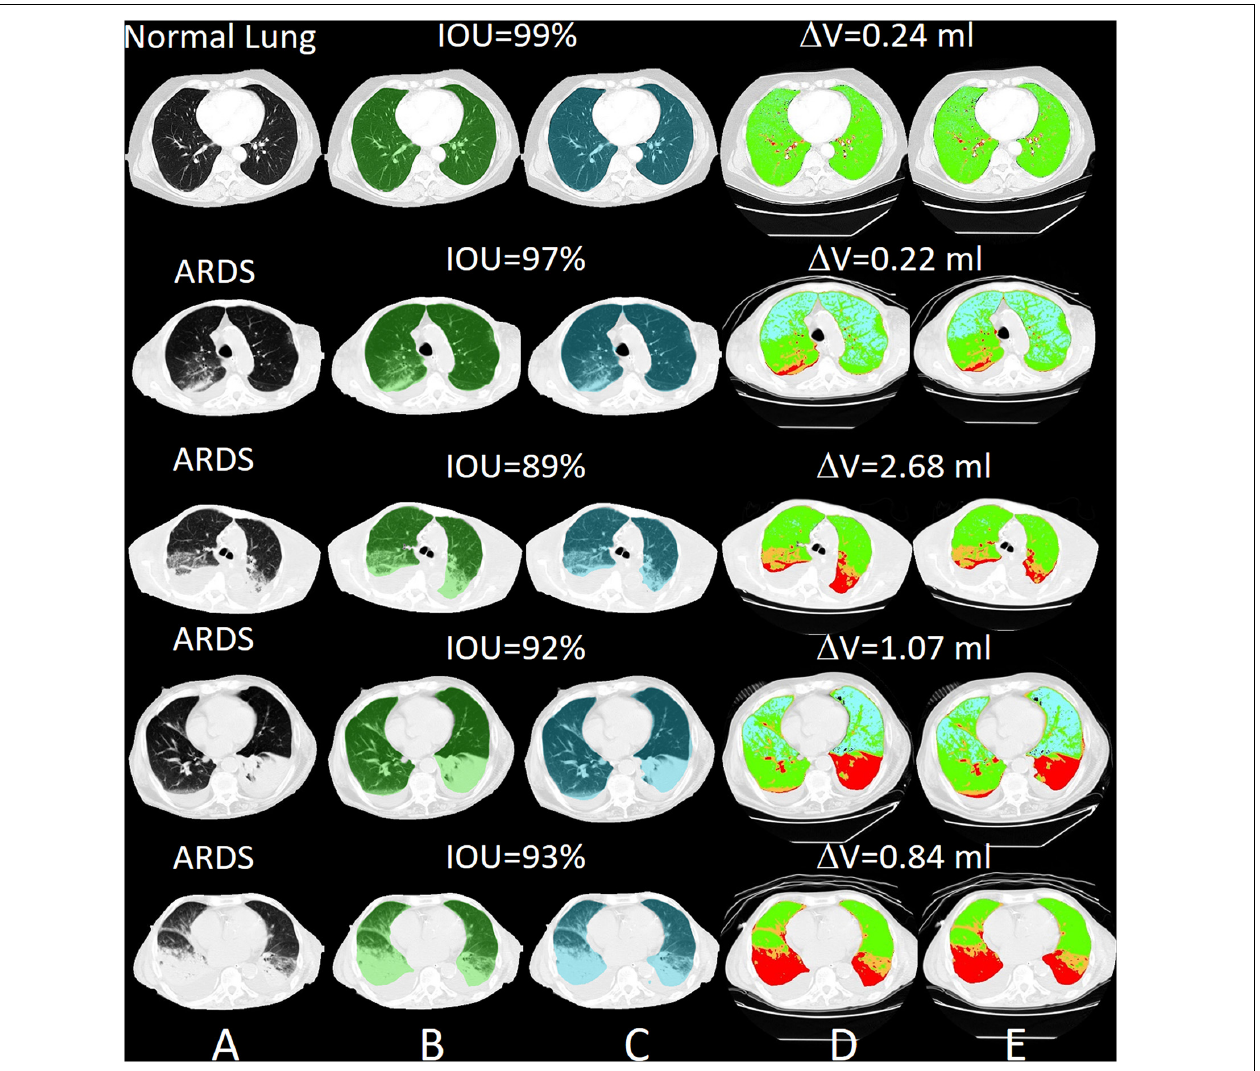
FIGURE 10 | Selected slices with very good segmentation results with an IOU of up to 99% with normal lungs. The differences in lung volume between manually and automatically segmented lungs are 0.24 ml. (A) preprocessed CT, (B) ground truth (transparent green), (C) predicted mask (transparent blue), (D) quantitative calculations within the manual ROI and (E) quantitative calculations within the automatic ROI (green = normally aerated, blue = over-inflated, orange = poorly aerated and red = not